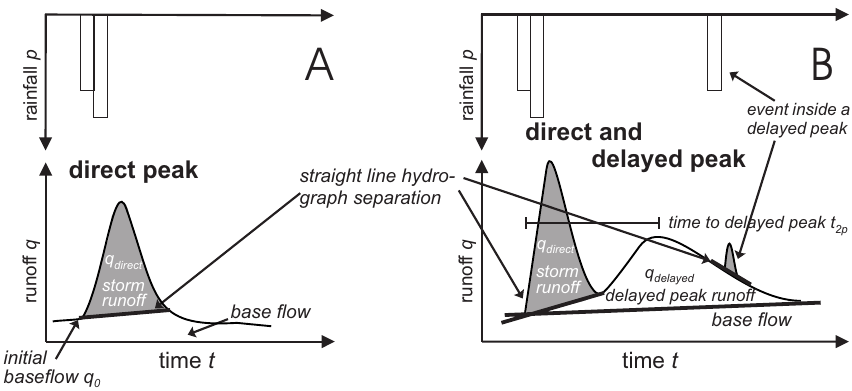
Fig. 4. Schematic representation of the hydrographs of an unimodal peak event (A) and a bimodal peak event (B) .